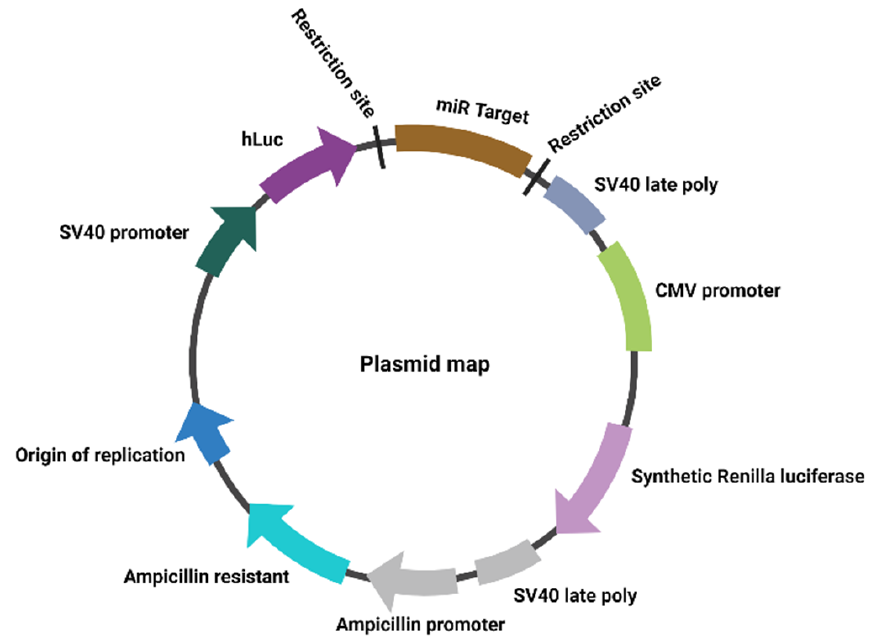
Figure 2. Generic vector map for all human plasmids used. SV40, Simian Virus 40 promoter; CMV, cytomegalovirus; hLuc, Firefly luciferase reporter gene. Modified from GeneCopoeia (Rockville, MD, USA) and LabOmics, Nivelles, Belgium.